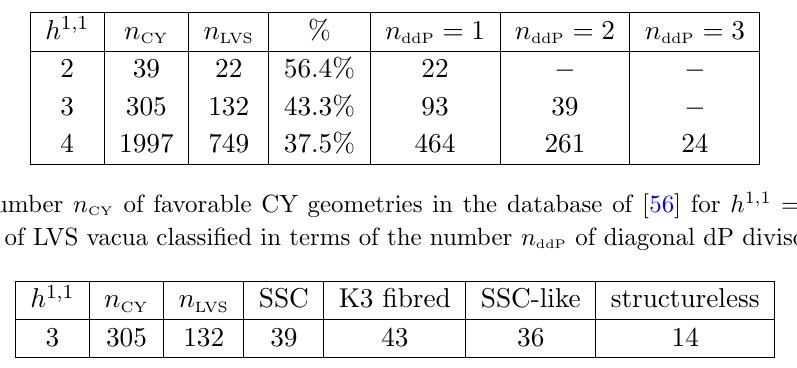
Table 2 . Di(cid:11)erent LVS subclasses for the cases in table 1 with h 1 ; 1 =